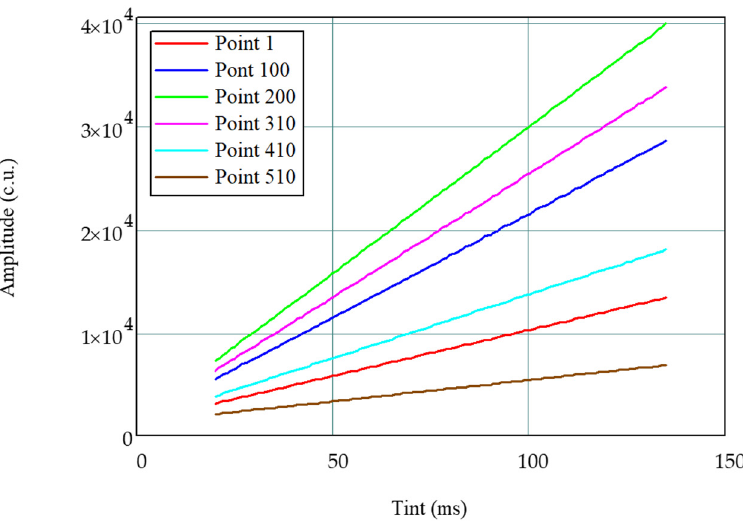
Figure 3. The dependence of the amplitude of different points of the spectrum on TINT.